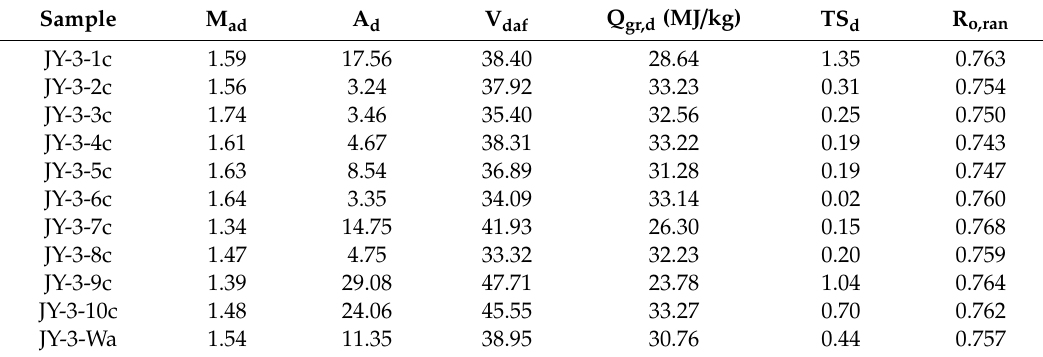
Table 1. Proximate analysis (%), gross calorific values (MJ / kg), and mean random vitrinite reflectance values (R o,ran ; %) of the coal samples from the Jinyuan Mine.